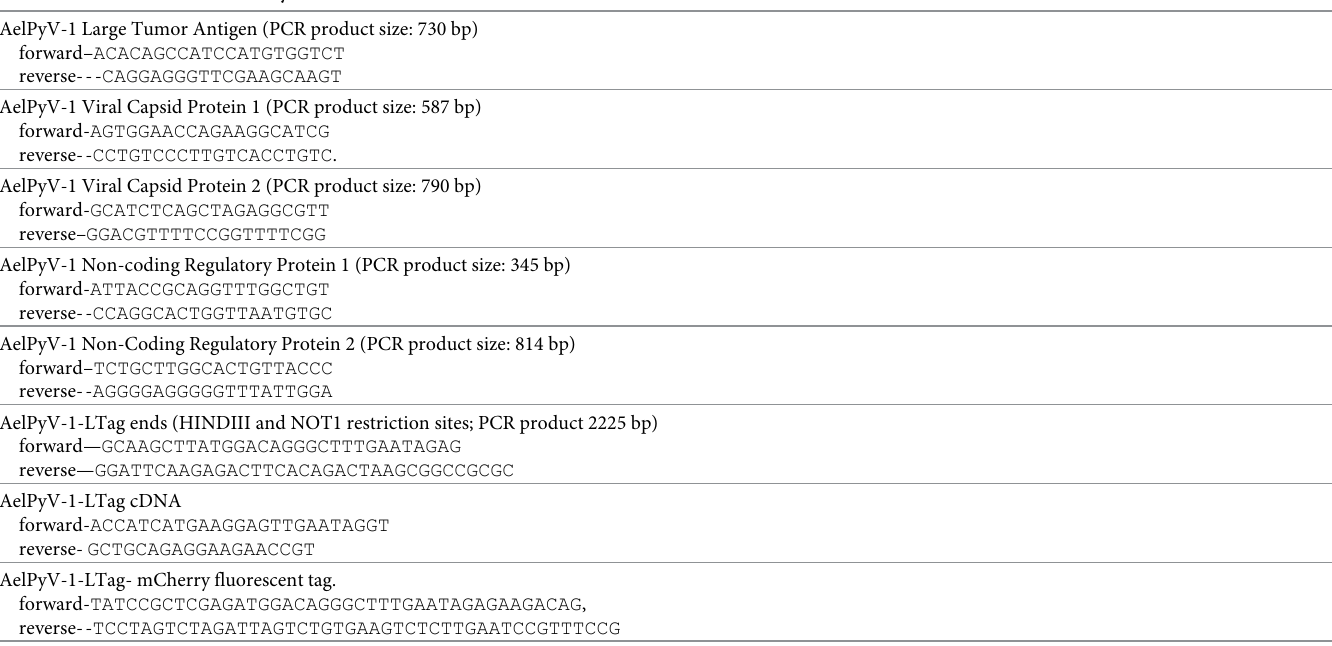
Table 1. Primers used in this